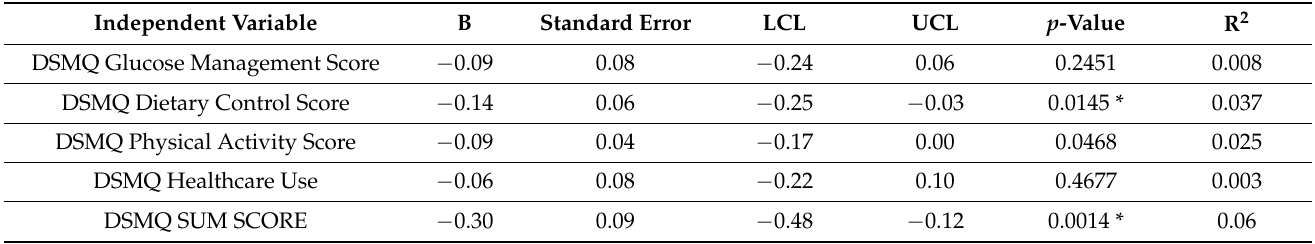
Table 2. Parameters of univariate linear regression between DSMQ questionnaire components and